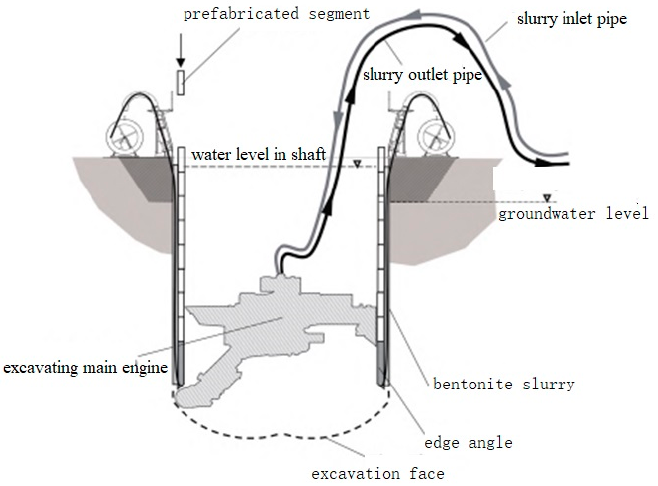
Figure 1. Schematic diagram of VSM construction method.